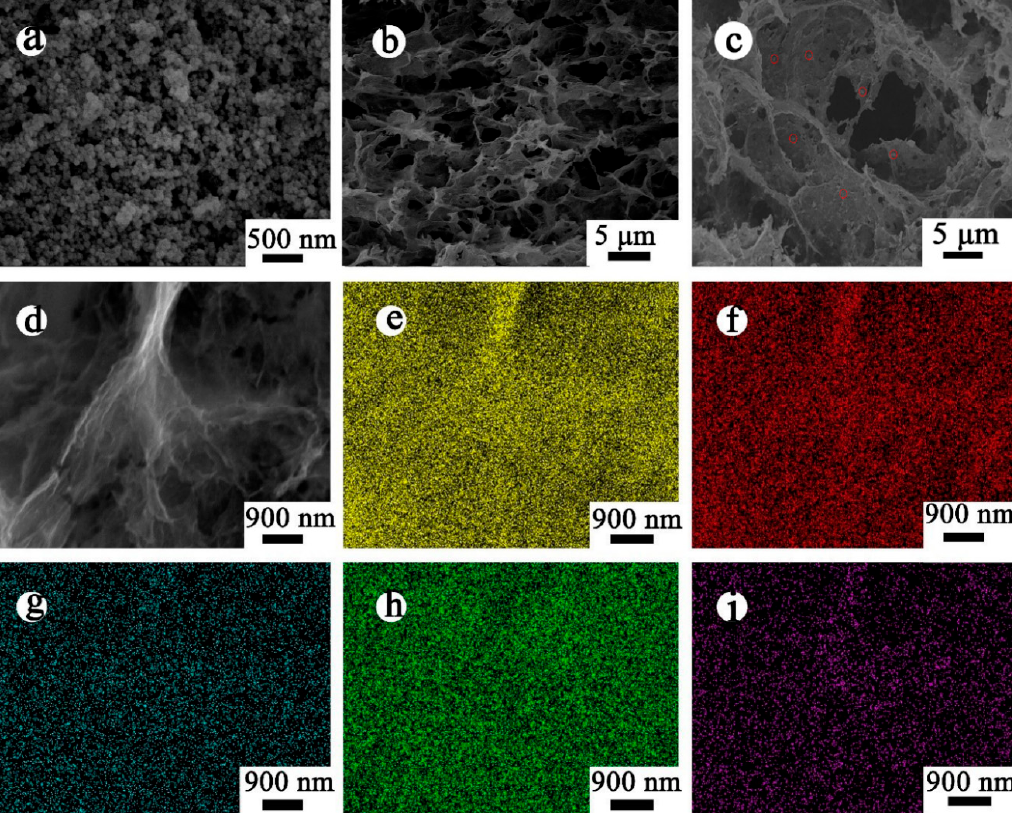
Figure 1. SEM images of ( a ) pure MnFe 2 O 4 , ( b ) BGA, and ( c ) MnFe 2 O 4 /BGA composite; ( d ) the elemental mapping region and ( e – i ) corresponding elemental mapping (C, O, Mn, Fe and B) images in MnFe 2 O 4 /BGA. Transmission electron microscope observation also confirmed the formation of MnFe 2 O 4 /BGA composite. From Figure 2a, it can be seen that the MnFe 2 O 4 nanoparticles with an average size around 16 nm are randomly distributed in the hierarchical networks of BGA. From the HRTEM image shown in Figure 2b, a MnFe 2 O 4 nanoparticle is observed. It is obvious that the typical d ‐ spacing of 0.245 nm for those well ‐ resolved lattice fringes corresponds to the (400) plane of MnFe 2 O 4 crystal.